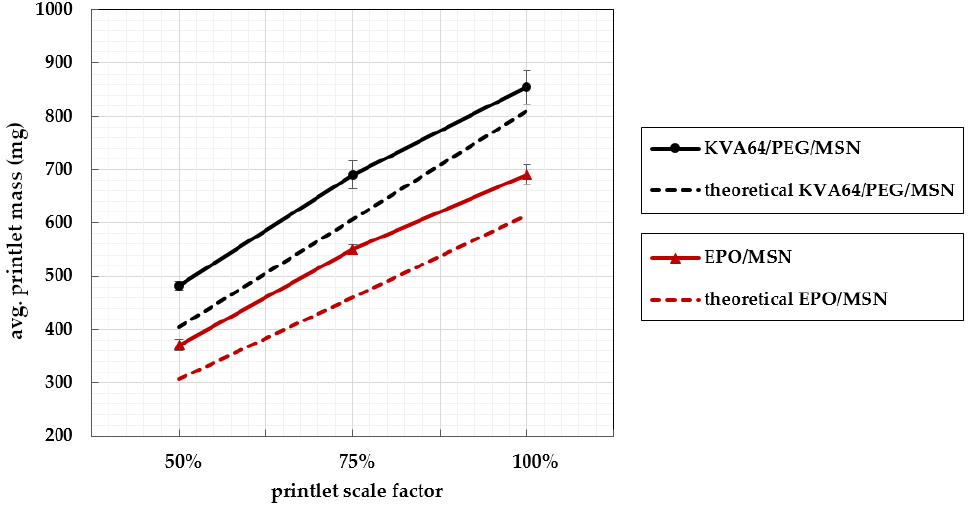
Figure 9. KVA64/PEG/MSN and EPO/MSN ’ s mean printlet masses with standard deviations versus the printlet volume scale factors 100%, 75%, and 50%.